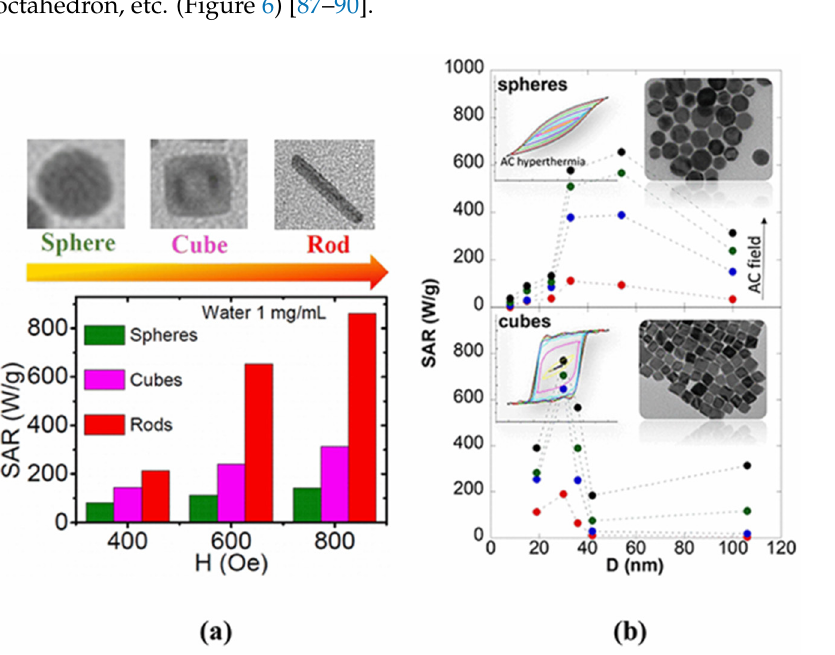
Figure 6. ( a ) SAR vs. H for the Fe 3 O 4 NPs (spheres, cubes, nanorods) with the volume of about 2000 nm 3 , ( b ) SAR vs. H for the sphere and cube-shaped Fe 3 O 4 NPs dispersed in water under AMF (300 kHz, from tens to 800 Oe). Reprinted with permission [87,88]. Copyright 2021, American Chemical Society.